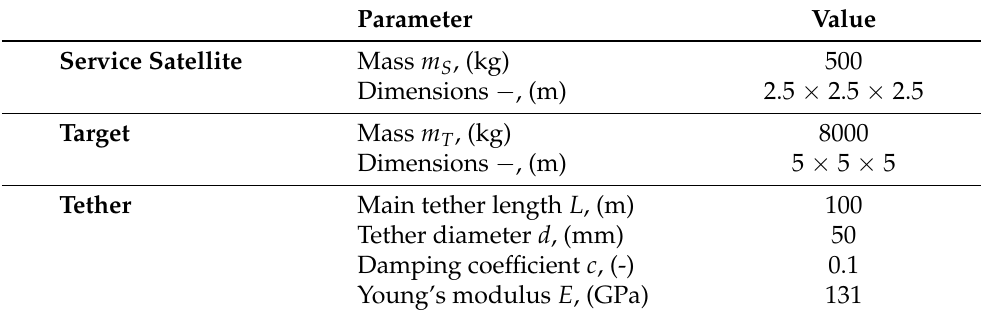
Table 6. Simulation parameters.